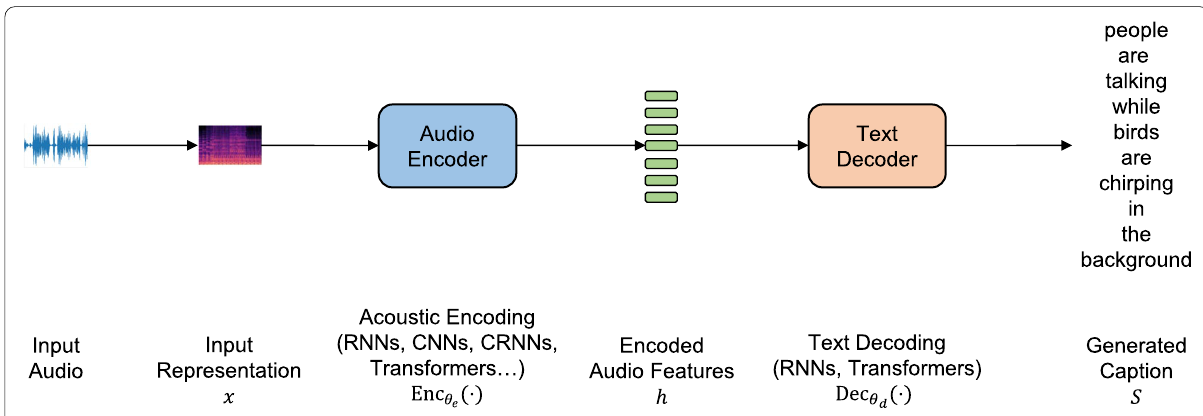
Fig. 1 Overview of an encoder-decoder-based AAC system, where the input is the waveform of an audio clip and the output is a natural language sentence describing the content of the input audio